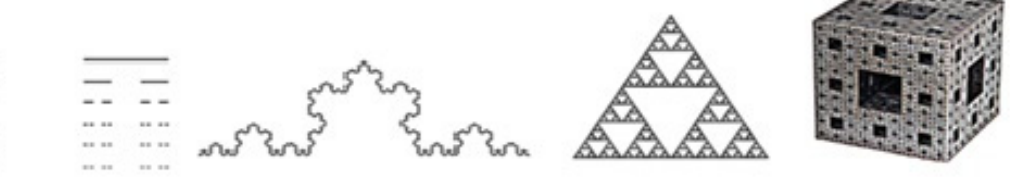
Figure 3. Classical fractals.